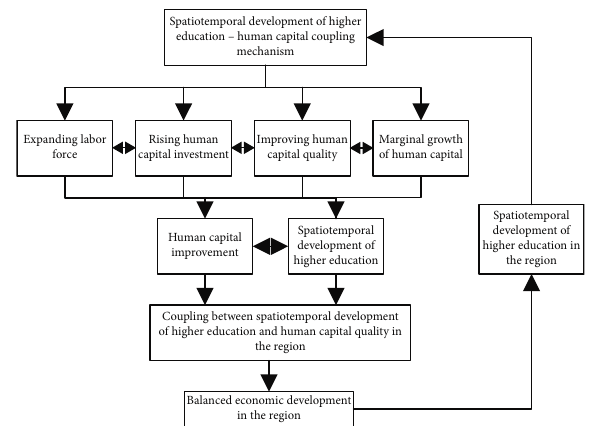
Figure 5: Principle of how human capital coupling mechanism affects regional economic growth.